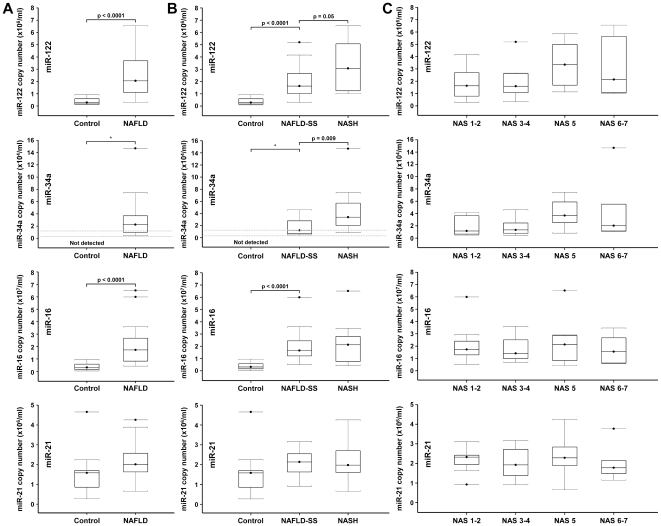
Serum levels of miR-122, miR-34a, miR-16 and miR-21 in NAFLD patients.(A) Expression of miR-122, miR-34a, miR-16 and miR-21 in serum from healthy controls and NAFLD patients. (B) NAFLD patients were divided into two groups based on the NAFLD activity score (NAS): NAFLD-simple steatosis (NAFLD-SS) with NAS≤4 and non-alcoholic steatohepatitis (NASH) with NAS ≥5. (C) NAFLD-SS and NASH groups were further subdivided based on individual NAS scores.